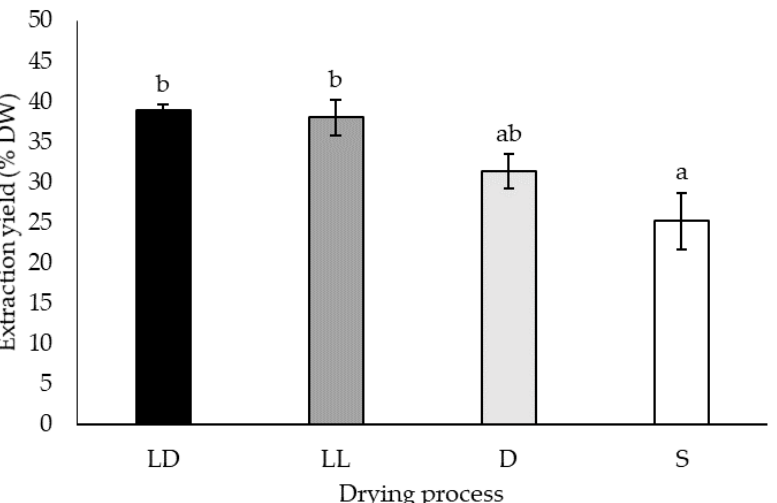
Figure 1. Global extraction yields in percentage of dry weight (% DW) obtained for ethanolic extraction of Agave lechuguilla bagasse freeze-dried in the dark (LD), exposed to light (LL), oven-dehydrated (D), and sun-dried (S). The given letters “a”, “b”, and “ab” indicate statistically significant results as per Kruskal – Wallis test (n = 3, p < 0.05).